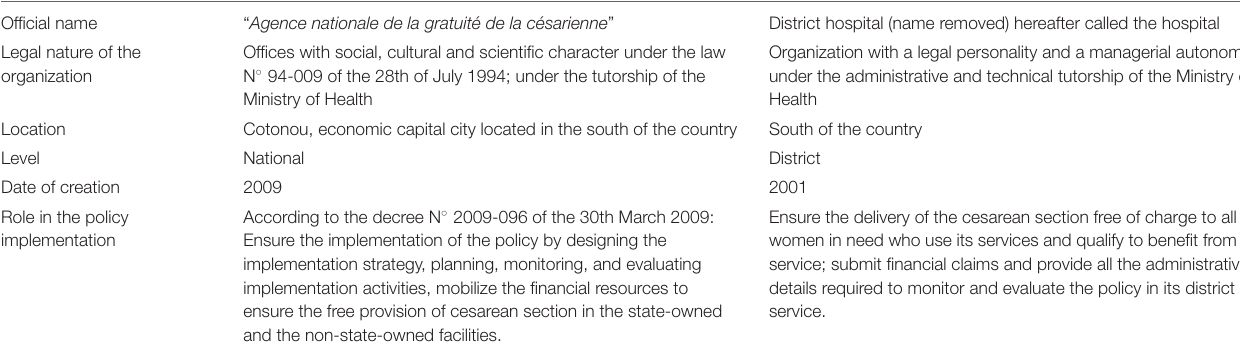
TABLE 1 | General characteristics of the units of analysis.